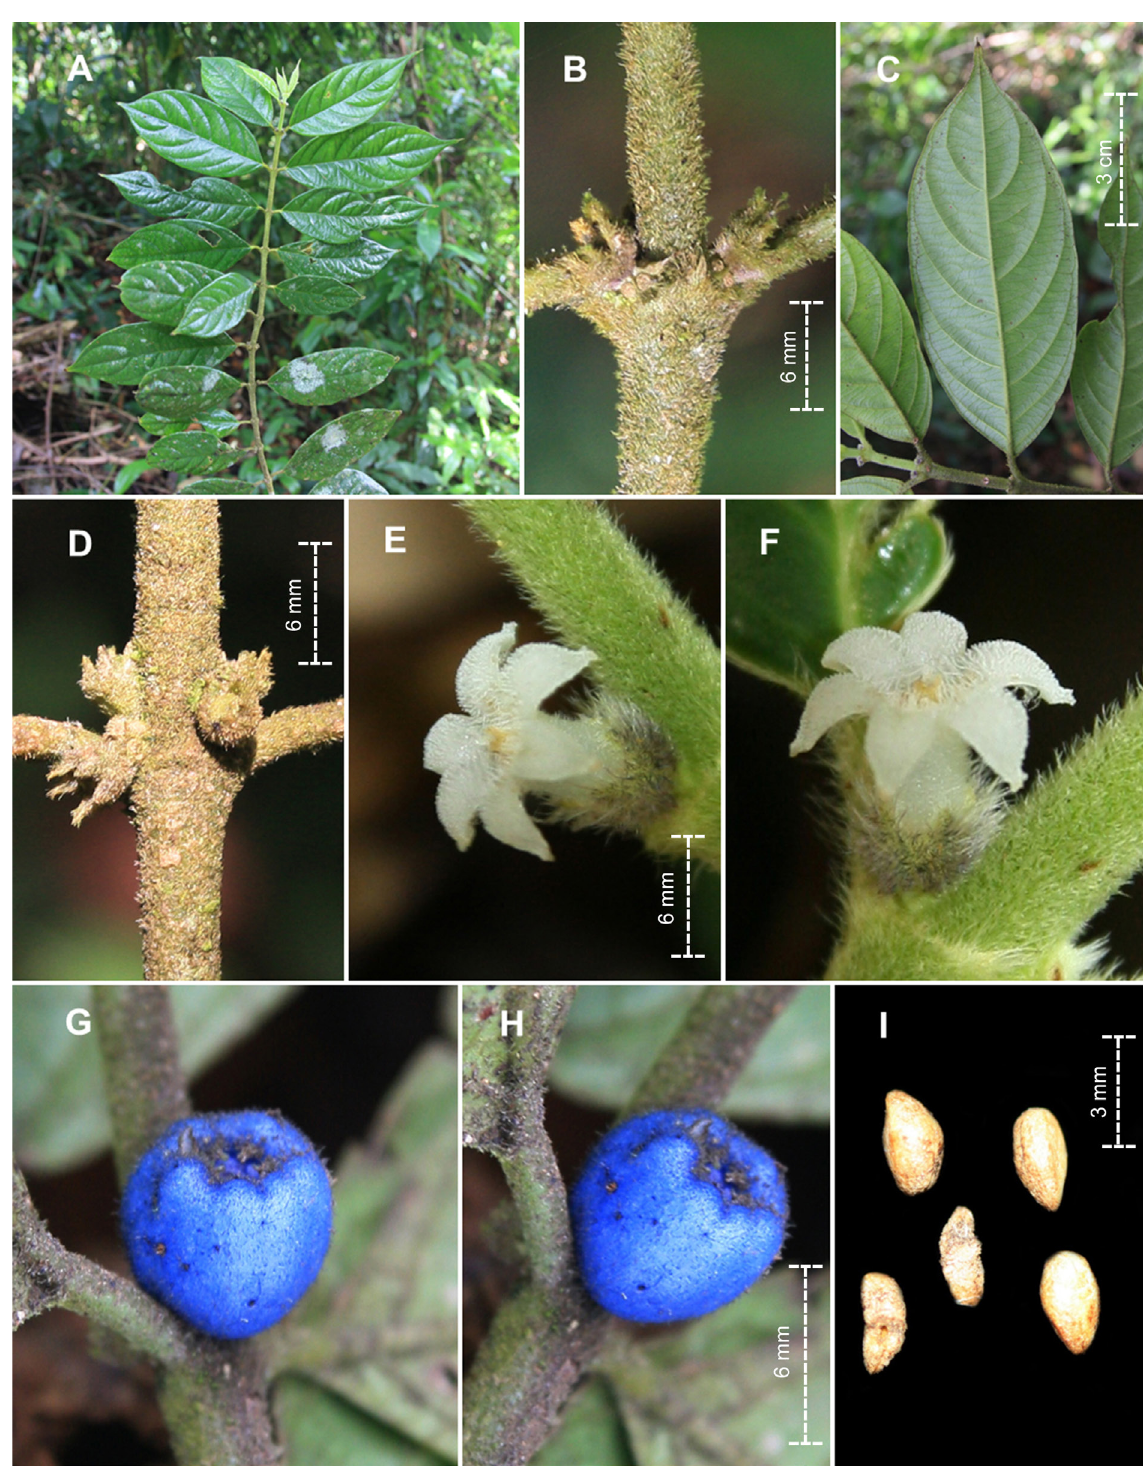
Fig. 1. Lasianthus naikii V.S.Dang & Vuong sp. nov. A . Branch. B . Stipule. C . Abaxial leaf surfaces. D . Calyces. E–F . Close-up of flowers. G–H . Mature fruits. I . Seeds. Photos by Van-Son Dang on 22 Apr.